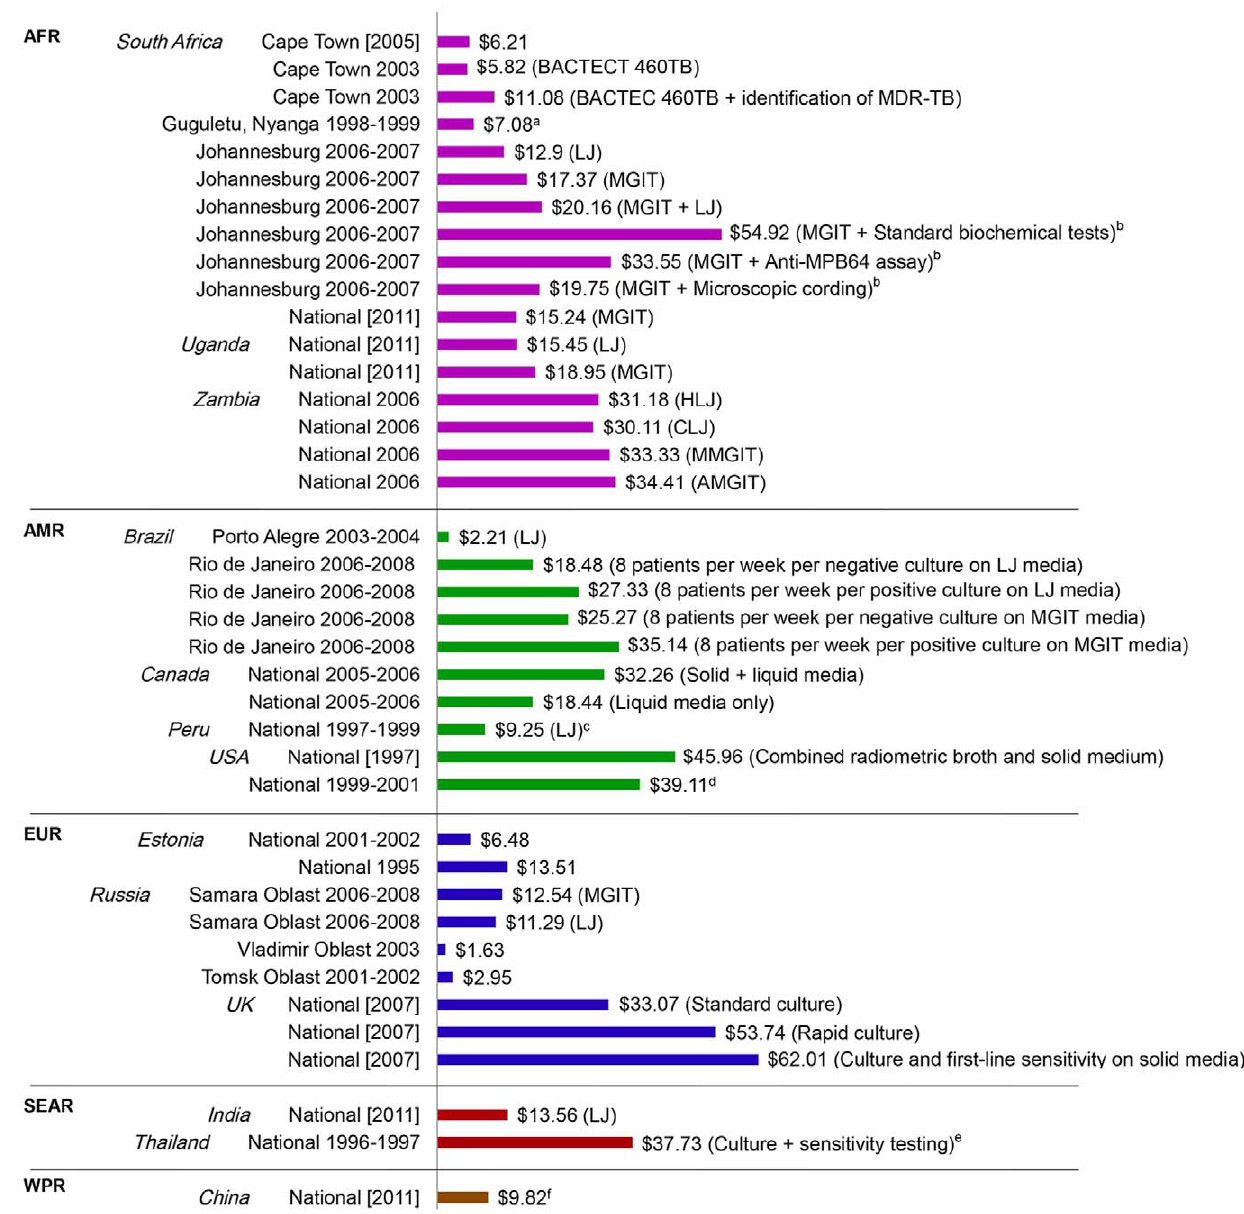
Figure 3. Unit cost in 2010 USD for culture test alone. (1) Cost data were sorted by WHO regions: African Region (AFR), Region of the Americas (AMR), Eastern Mediterranean Region (EMR), European Region (EUR), South-East Asia Region (SEAR) and Western Pacific Region (WPR). (2) For studies with available details on test methods, we labeled them at the end of each bar. (3) ‘‘[]’’ indicates publication year when data collection year is not available. (4) LJ: Lo¨wenstein-Jensen; MGIT: Mycobacteria Growth Indicator Tube; HLJ: Homemade Lo¨wenstein-Jensen; CLJ: Commercially Lo¨wenstein- Jensen; MMGIT: Manually Mycobacteria Growth Indicator Tube; AMGIT: Automated Mycobacteria Growth Indicator Tube; FIND: Foundation of innovative New Diagnostics; BD: Becton Dickinson. a $ 7.08 is the average costs between negative and positive tests. b The paper indicates cost for organism identification per positive culture on MGIT was $ 37.55 for using standard biochemical tests, $ 16.18 for anti-MPB64 assay and $ 2.38 for cording; we added each of them to the cost per MGIT ( $ 17.37) for calculating the cost for positive culture. c $ 9.25 is the total cost of $ 85.07 divided by 9.2 sputum cultures. d Sum of the cost for sputum collection ( $ 19.12) and the cost for bacterial culture ( $ 19.99). e Sum of the overhead cost ( $ 10.4) and the material cost ( $ 27.33). f The unit cost is the average over six regional estimates. For detailed information of the six regional estimates, see Table